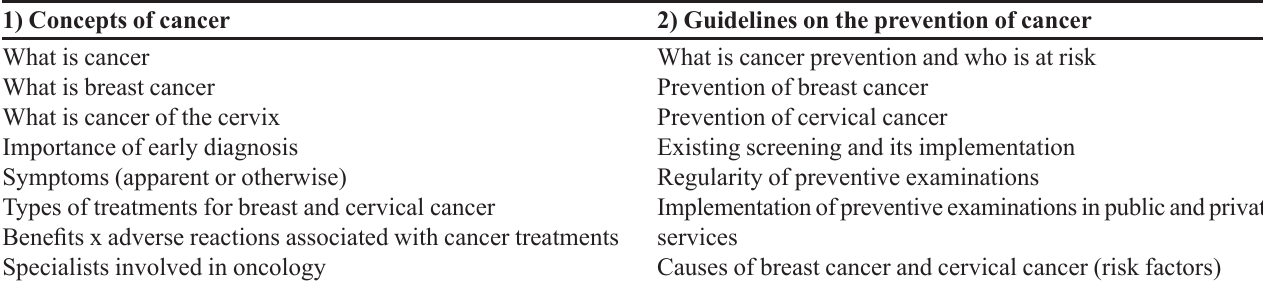
TABLE II - Proposed guidance on interventions for the prevention of cancer in women 1) Concepts of